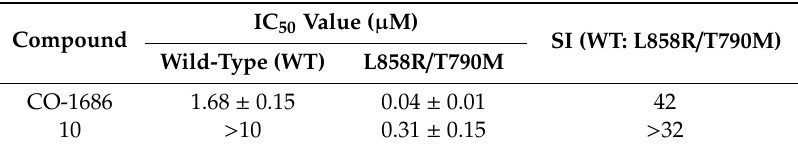
Data represent the mean ± SD of three separate